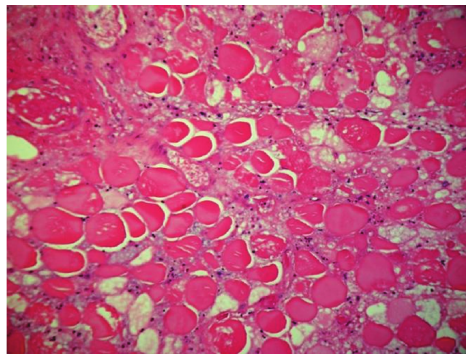
Figure 2: Histologic appearance of muscle tissue demonstrating coagulation necrosis in skeletal muscle (Hematoxylin-eosin stain: original magnification 200X).